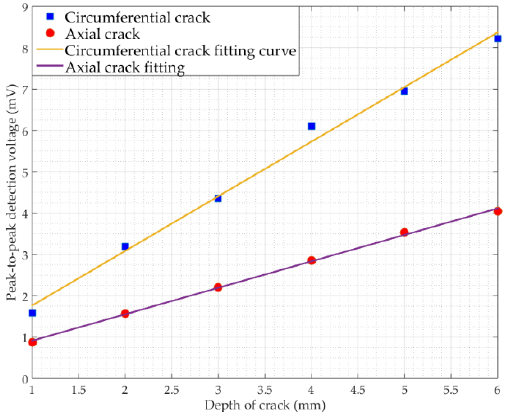
Figure 12. The relationship between the crack depth and the amplitude of the detection signal.